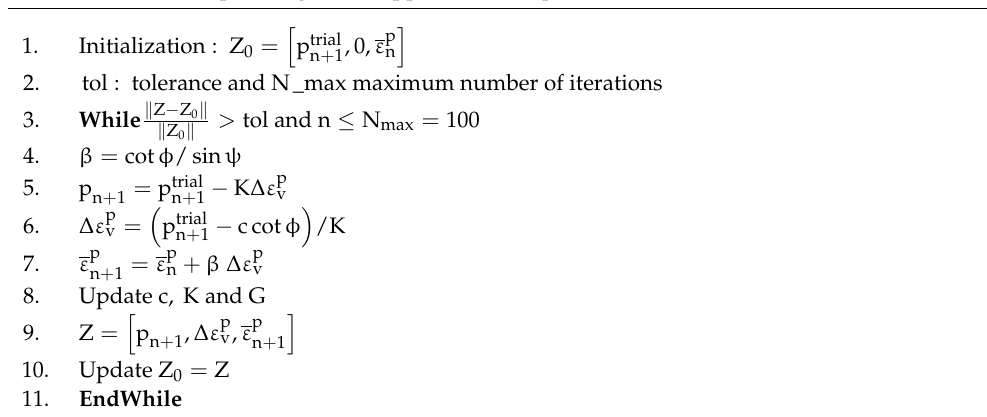
Algorithm 6 : Fixed point algorithm applied to the Apex